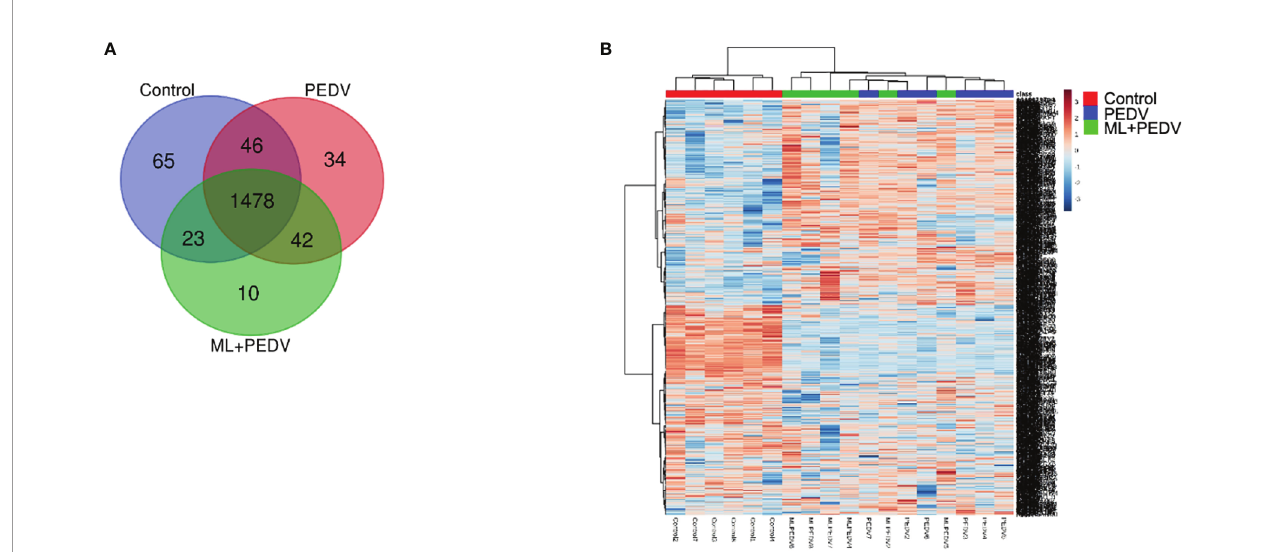
FIGURE 5 | Overview of all differentially expressed proteins (DEPs) among the control, PEDV and ML + PEDV groups by proteomic analysis. The Venn diagram (A) showed the total number of identi fi ed proteins in the three groups. The heat map (B) showed the convergence of DEPs among different groups.